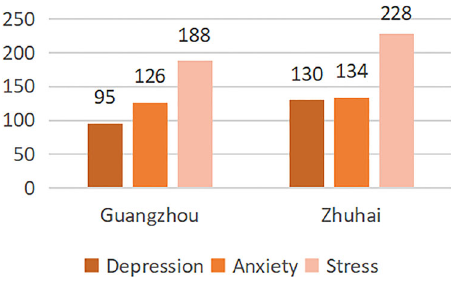
level is higher than